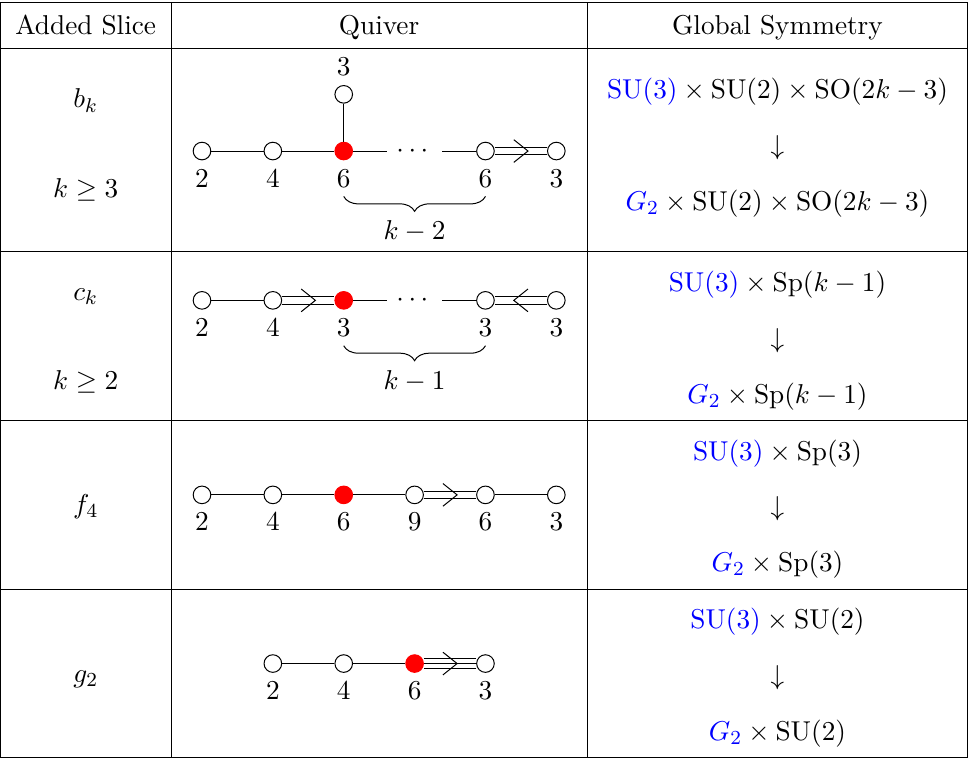
Table 13 . Quivers resulting from adding all possible non-simply laced elementary slices to the existing nodes of sub-regular G (5.1) to absorb a 2